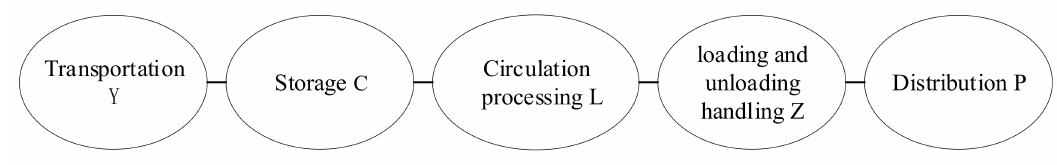
Figure 2. Structural diagram of a typical tandem logistics